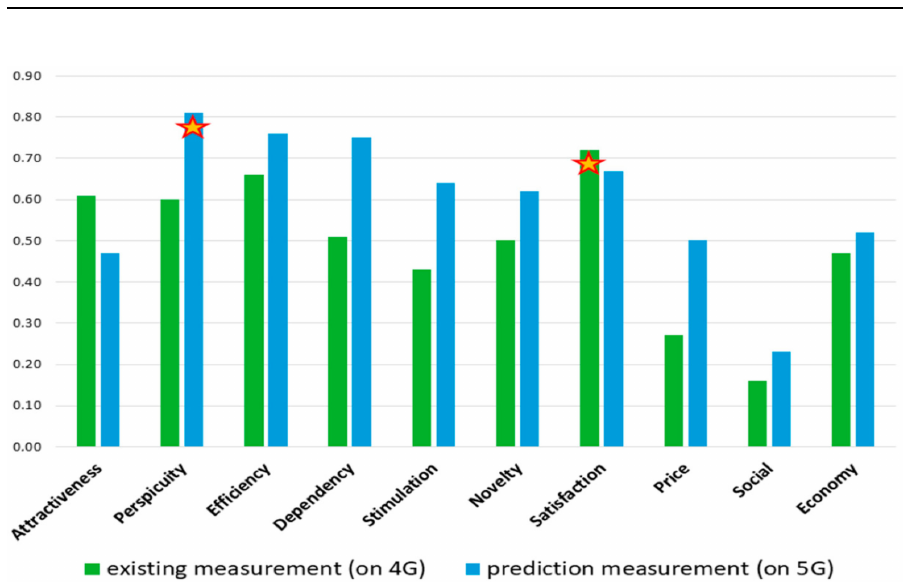
Figure 4. Comparison chart of correlation values for UX video streaming in